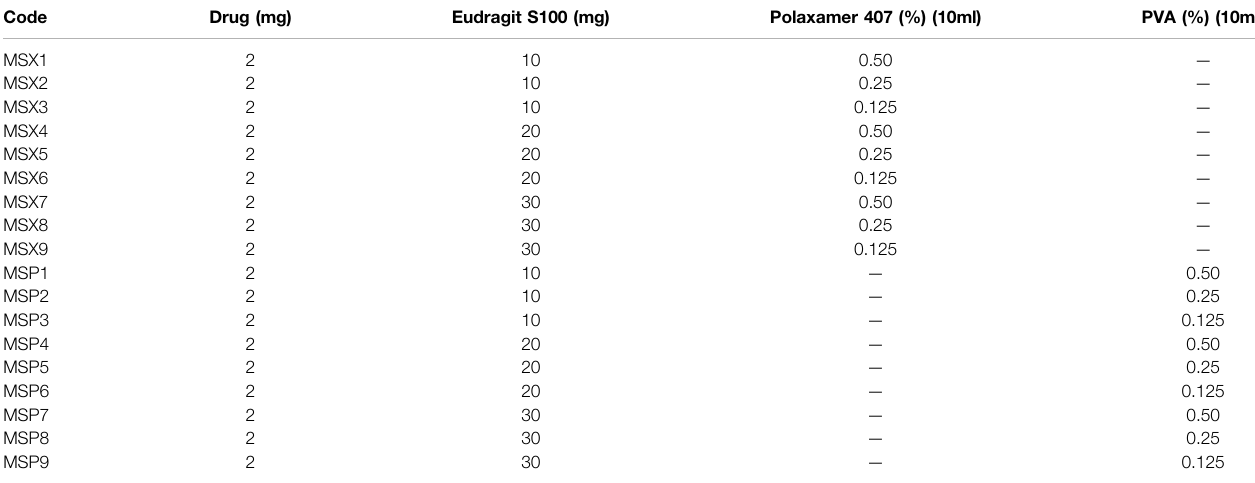
All formulations are prepared at 25 ° C and 99% sonication speed.